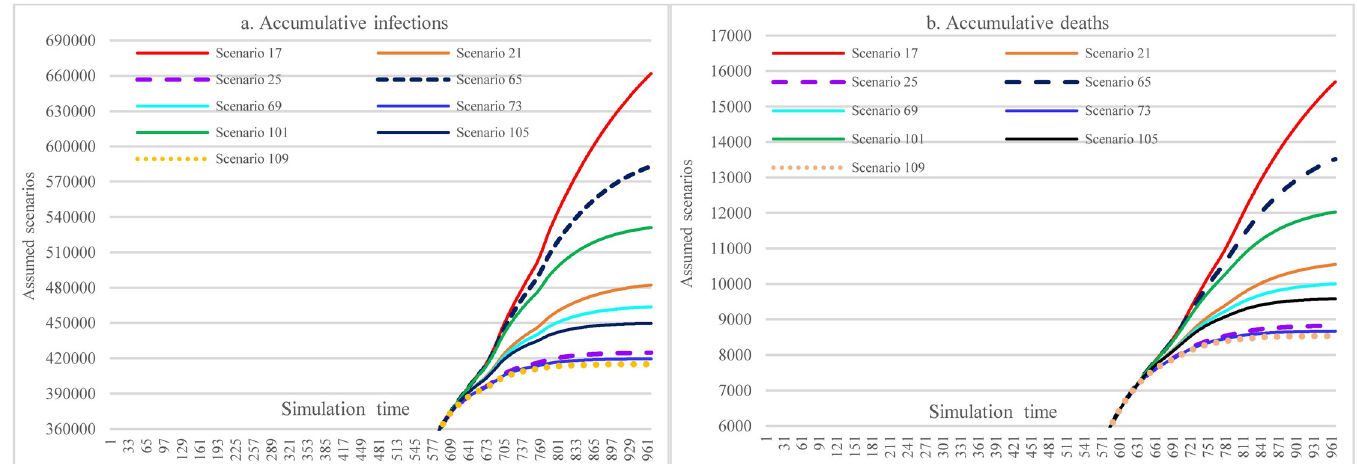
Fig 17. Impacts of changing vaccination levels and implementing social distancing measures with mask-wearing adherence level of 48%.